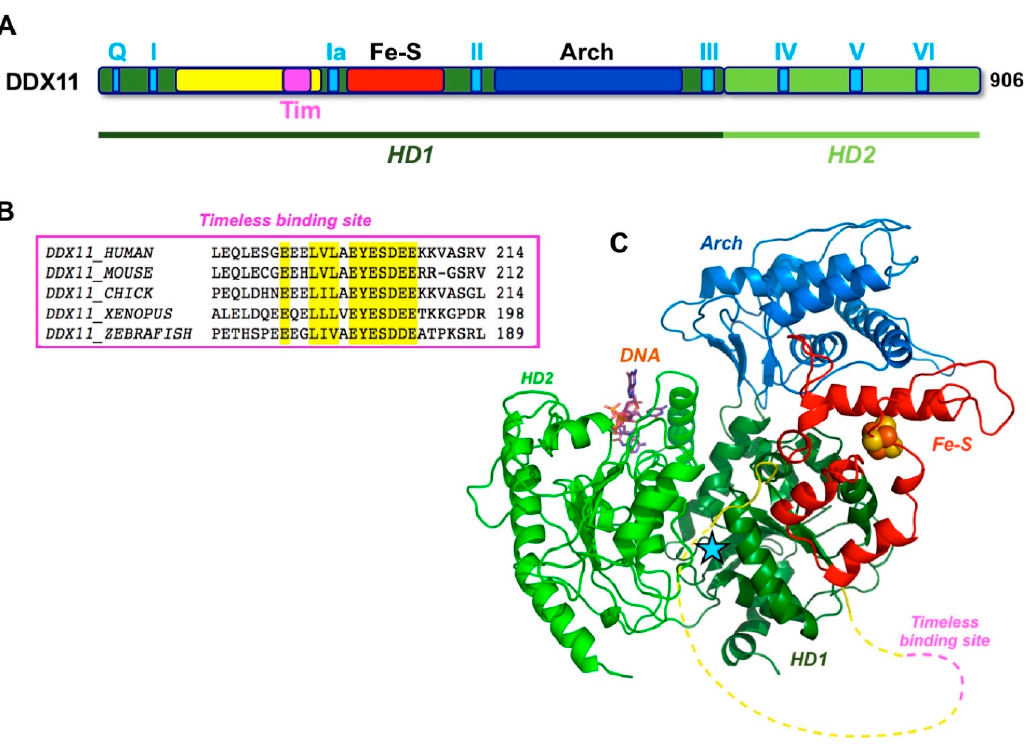
Figure 3. Architecture of human DDX11 . ( A ) Schematic representation of the architecture of DDX11, highlighting the location of the catalytic core domains HD1 ( dark green ) and HD2 ( light green ). The other domains and motifs are shown using the same colour code as in Figure 1. ( B ) A close-up of the sequence conservation in the DDX11 region that has been shown to bind Timeless; the sequences of the human, mouse, chicken, Xenopus and zebrafish orthologs are shown; the residues that are conserved in all sequences are highlighted in yellow . ( C ) A homology model for the human DDX11 helicase, with domain colour-coded as in panel A ; the position of the DNA is taken from the structure of an archaeal XPD (PDB ID: 4A15); a light blue star indicates the position of the active site. A yellow dotted line shows the partially disordered insertion, including the Timeless-binding region (in magenta ).